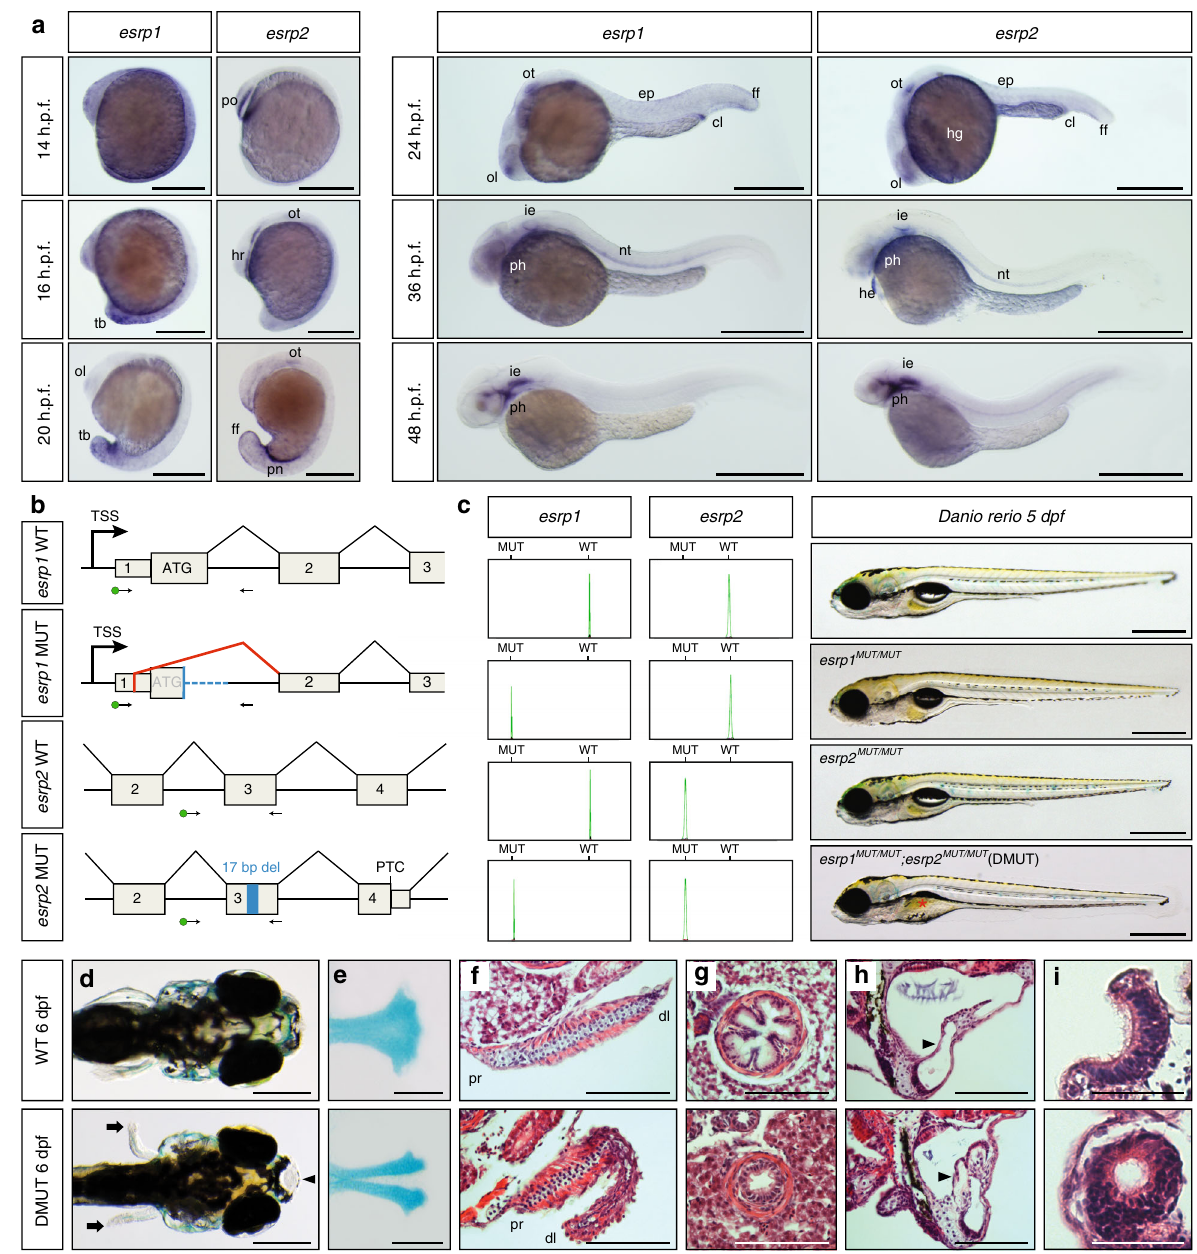
Fig. 1 Expression and developmental roles of esrp1 and esrp2 in zebra fi sh. a WMISH for esrp1 and esrp2 in Danio rerio WT embryos. At 14 h.p.f., esrp1 transcripts were observed in embryonic epidermis, while esrp2 expression was only detected in the polster (po). At 16 h.p.f., esrp1 was restricted to the posterior and tailbud (tb) epidermis, whereas esrp2 persisted in the hatching gland rudiment (hr) and mild expression started to be detected in the otic placode (ot). By 20 h.p.f., esrp1 was found in the tailbud epidermis and more subtly in the olfactory placode (ol), while esrp2 appeared in new territories, such as pronephros (pn) and ectodermal cells of tailbud fi n fold (ff). At 24 h.p.f., expression of both paralogs presented a similar pattern including olfactory and otic placodes, cloaca (cl), and epidermis (ep), although esrp2 was also observed in the hatching gland (hg). By 36 h.p.f., both genes were detected in the inner ear epithelium (ie), notochord (nt), and phanynx (ph), and esrp2 was also observed in the heart (he). At 48 h.p.f., expression was found predominantly in inner ear and pharynx. b Schematic representation of the genomic and transcriptomic impact of the selected esrp1 and esrp2 mutations. Blue boxes/lines represent genomic deletions in the mutants, while the red line depicts an altered splice junction in the esrp1 mutant allele. TSS, transcription start site; PTC, premature termination codon; del, deletion. Standard and fl uorescent (green dot) primers used during genotyping are represented by arrows. c Left: genotyping of embryos by fl uorescent PCR readily distinguished between WT and MUT alleles. Right: Representative 5 d.p.f. larvae for wild type (WT), esrp1 mutant ( esrp1 MUT/MUT ), esrp2 mutant ( esrp2 MUT/MUT ), and double mutant (DMUT) genotypes. De fl ated swim bladder in the DMUT embryo is indicated by a red asterisk. d – i Phenotypic differences between 6 d.p.f. WT (top) and DMUT (bottom) embryos in different embryonic structures. DMUT larvae showed impaired fi n formation (arrows) and cleft palate (arrowhead) d , including malformation of the ethmoid bone, as shown by Alcian blue staining e . f – i Transversal histological sections stained with hematoxylin and eosin showing structural differences in pectoral fi n f , esophagus g , inner ear h and olfactory epithelium i . Black arrowheads mark the dorso-lateral septum between semicircular canals in h . Proximal (pr) and distal (dl) parts of the fi n are indicated in f . Scale bars: 1 mm a , 2 mm c – e , 100 µ m f – h , 50 µ m